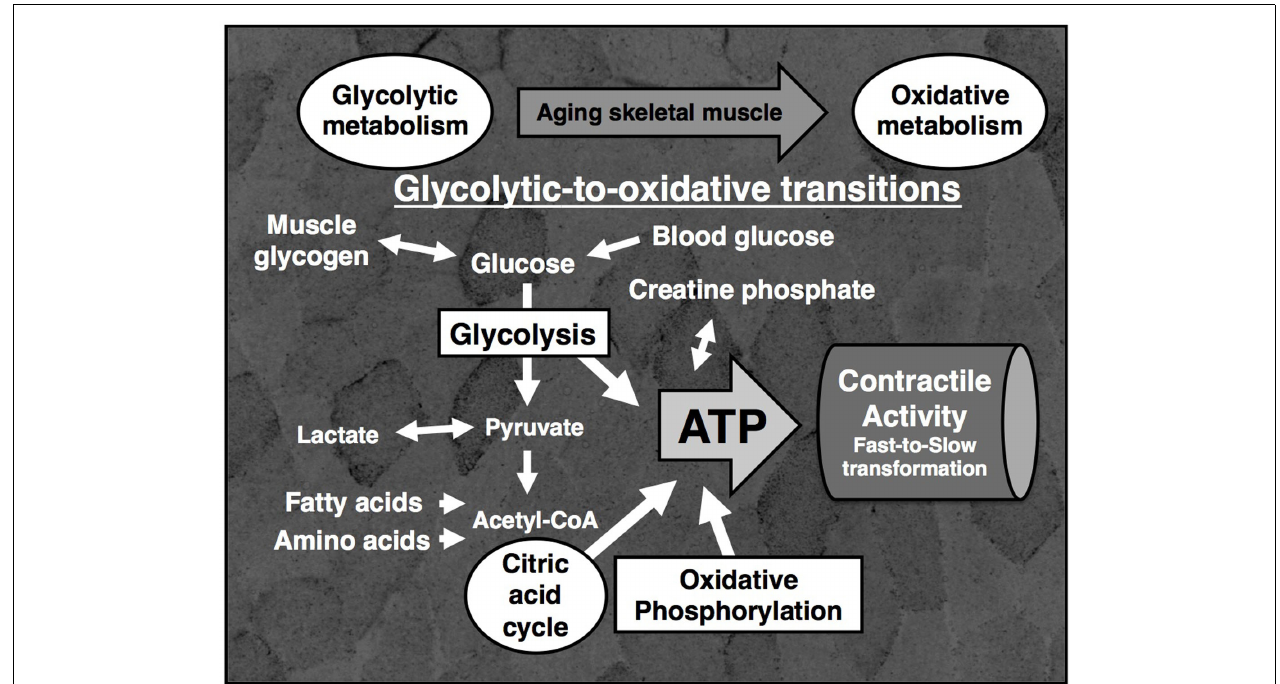
established an increase in mitochondrial enzymes and concomitant decrease in glycolytic enzymes during the fast-to-slow transformation process in aging skeletal muscle tissue.The background shows a transverse section of gastrocnemius muscle that was histochemically stained for the presence of the mitochondrial marker enzyme succinate